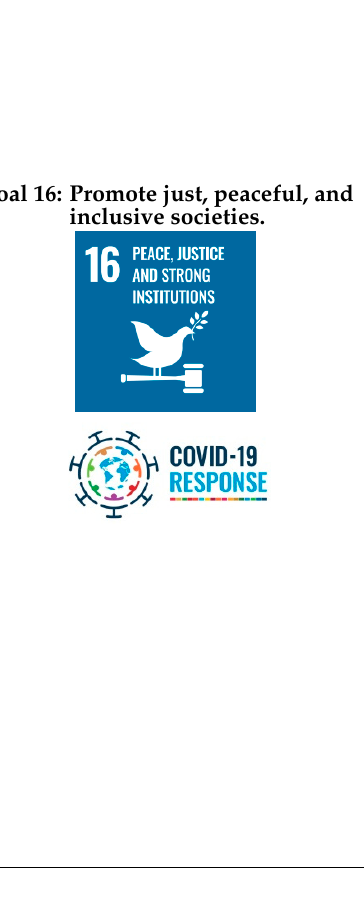
Table 5. Impact of the Sustainable Development Goals on IoT applications for improving health and the environment. SDGs Targets Goals and Application to IoT